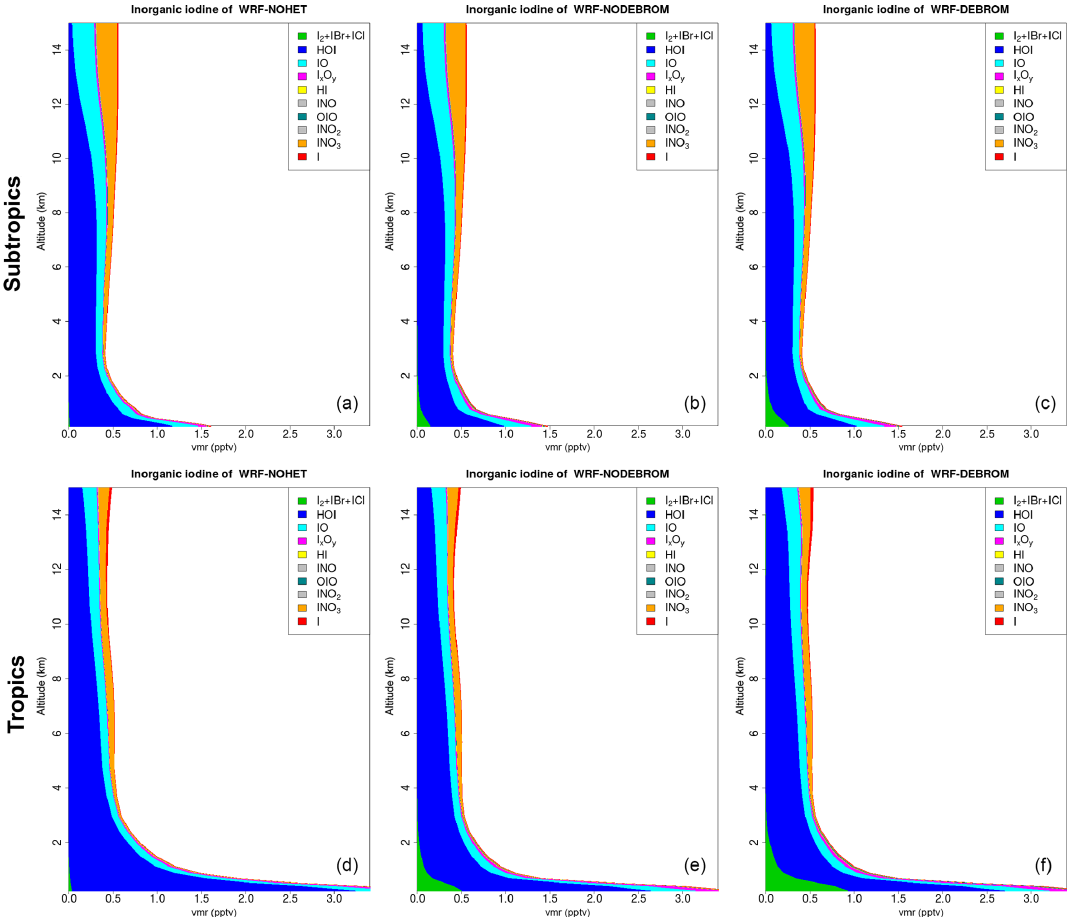
Figure 10. Regional average vertical partitioning of inorganic iodine (I y ) for the three different simulations – WRF-NOHET (a, d) , WRF- NODEBROM (b, e) and WRF-DEBROM (c, f) – during January and February 2012. Panels (a, b, c) are over the subtropical area and panels (d, e, f) over the tropical. Units are in